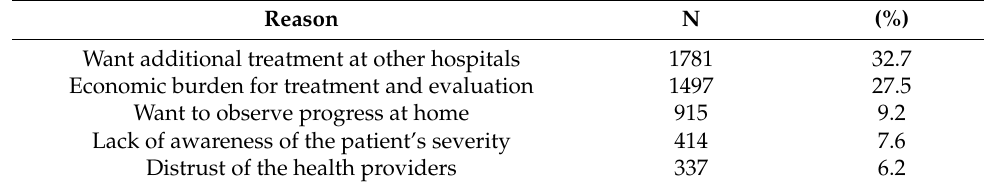
Table 3. The reason for discharge against medical advice ( n = 5445).